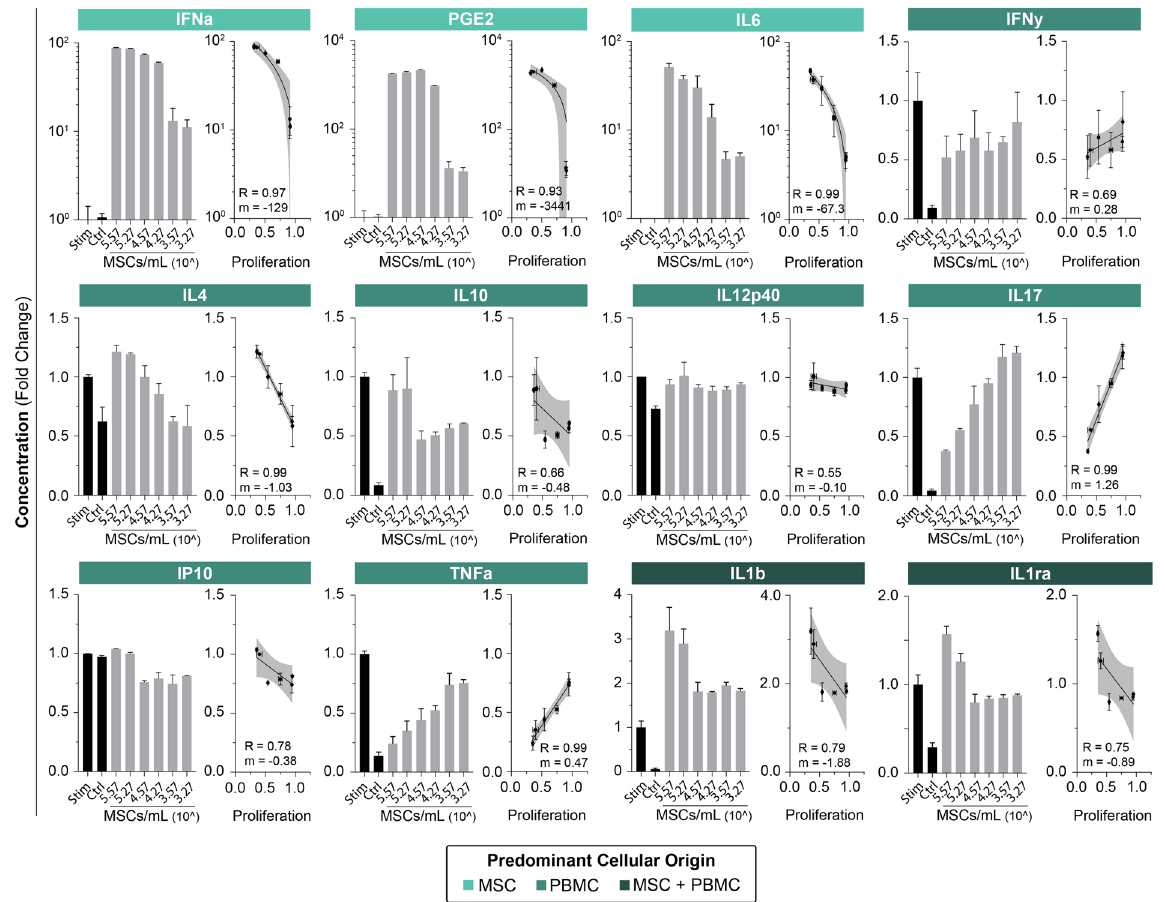
Figure 2. Biochemical profiling of PBMCs in response to MSC immunomodulation. PBMC proliferation was attained through stimulation with ConA and IL2 for a period of 4 days. Cytokines are binned based on their predominate origin: MSC, PBMC, or both. Bar graphs of normalized cytokine secretion versus cell concentration; bar graphs and data points represent mean + / − SD of 3 samples. MSC derived factors (IFNa, PGE2, and IL6) are highly correlated with MSC numbers. We further find that MSCs broadly downregulate secretions of pro-inflammatory cytokines (IFNy, IL17, TNFa) while promoting anti-inflammatory factors (IL4, IL10). Factors secreted by both populations (IL1b and IL1ra) demonstrate a stepwise change with moderate correlation. Correlative lines were generated using a linear